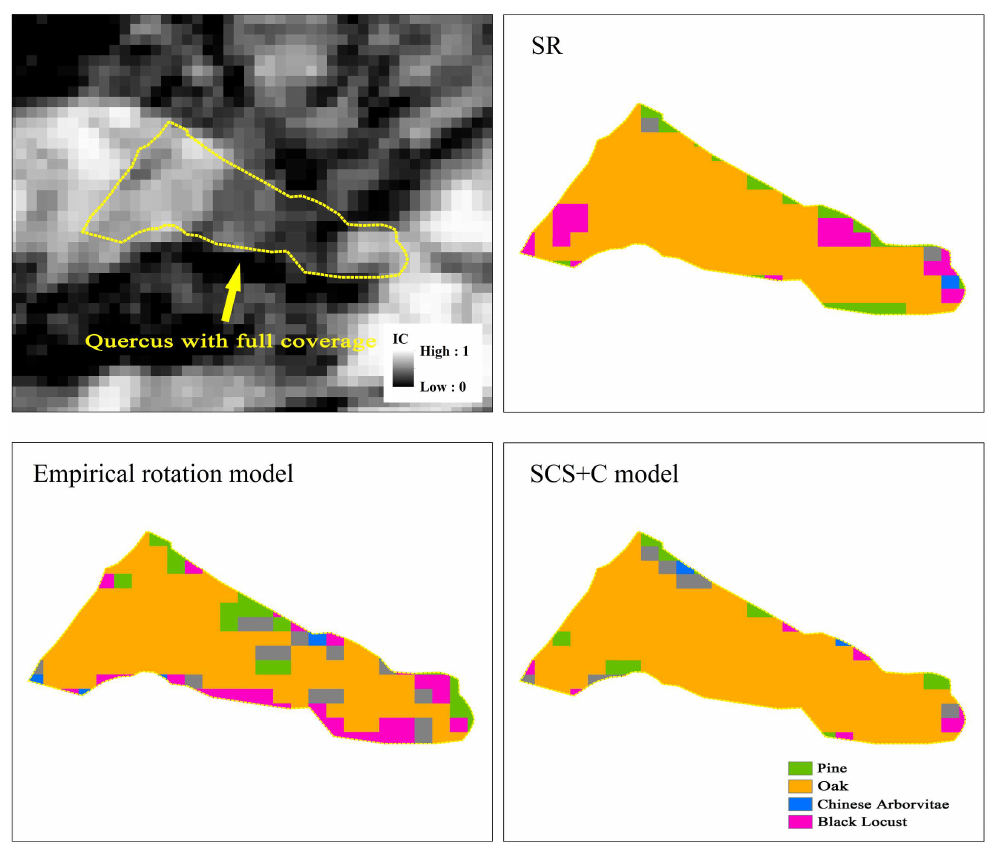
Figure 10. Contrast map of oak classification in full-coverage areas by using shadowless training data. SR represents the precorrected conditions of the classification result. The model represents the classification result after topographic corrected by the specific